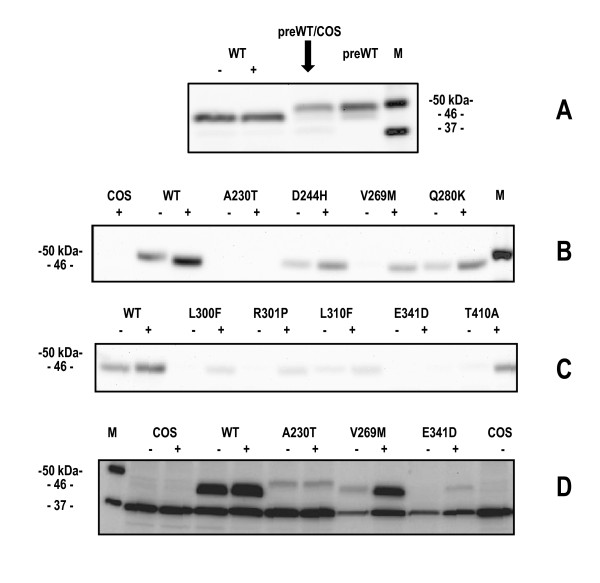
Effect of 1-deoxy-galactonojirimycin on various mutant of alpha-galactosidase expressed in COS-7 cells. Western blot analysis. Cells were cultured in the presence (+) or absence (-) of 20 uM 1-deoxy-galactonojirimycin for 2 days prior to western blot analysis. Panel A: WT-, COS-7 transfected with wild type AGAL (20 micrograms of cell extract); WT+, COS-7 transfected with wild type AGAL and treated with 20 micromolar 1-deoxy-galactonojirimycin (15 micrograms of cell extract); preWT/COS, COS-7 tranfected with void vector (20 micrograms) plus alpha-galactosidase precursor form (Fabrazyme® 20 nanograms), preWT, alpha-galactosidase precursor form (Fabrazyme® 20 nanograms); M, marker;. Panel B,C,D: COS-7 transfected with void vector (COS7), wild-type (WT) or mutant alpha-galactosidase vectors (10 micrograms) not treated (-) or treated with 1-deoxy-galactonojirimycin (+).